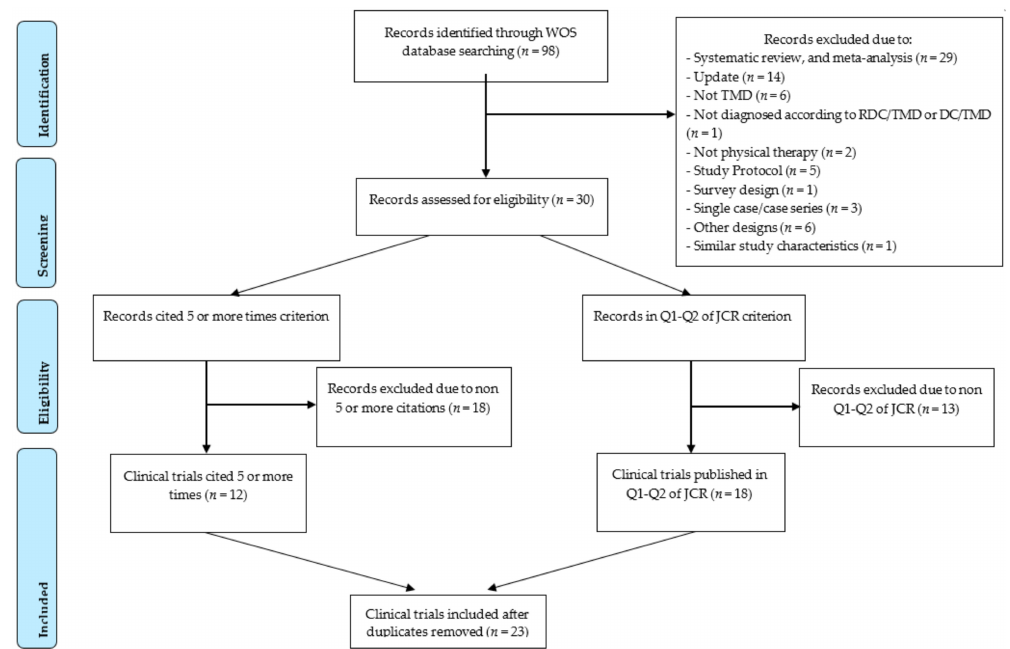
Figure 1. PRISMA Extension for Scoping Reviews (PRISMA-ScR) flow